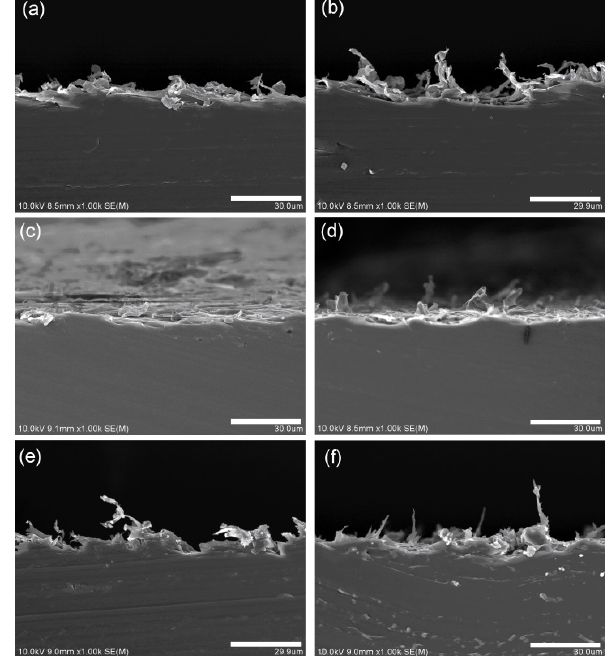
Fig. 8 The SEM micrograms of the cross-section of the scraped (left), bonded and peeled (right) HDPE (a, b), LDPE (c, d) and PP (e, f) samples scraped with the abrasive paper